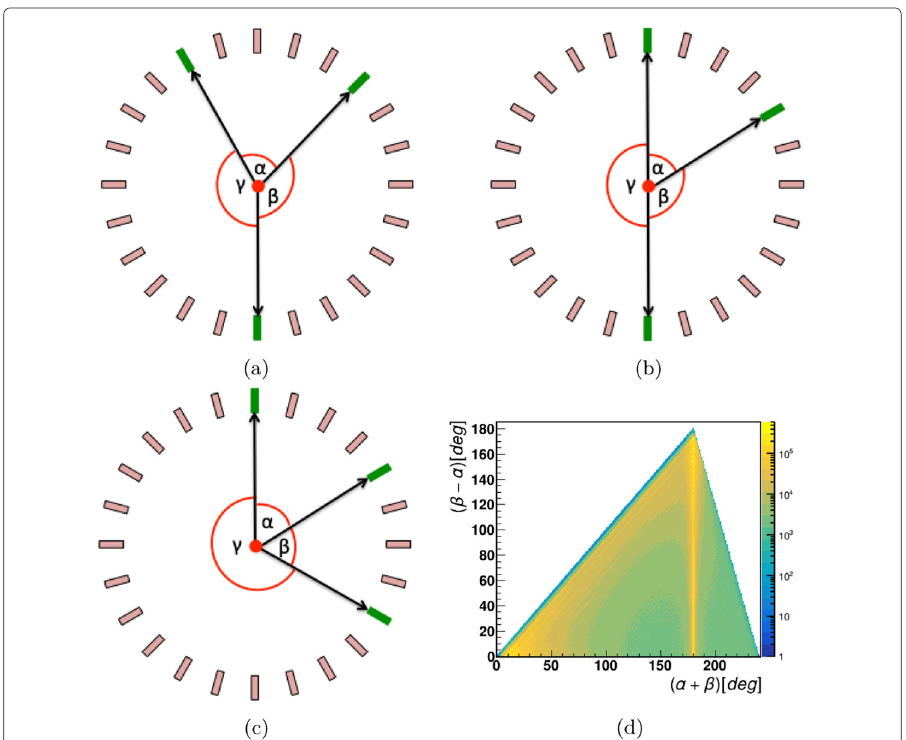
Fig. 6 a – c The three cases based on the angular correlation between the 3 hits in an event. The origin of the visualized events is explained in the text. a The case when the sum of two smallest angles is greater than 180 ◦ . b The case when sum is 180 ◦ . c When the sum of two smallest angles is less than 180 ◦ . d The measured scatter plot of the difference ( β − α ) vs the sum ( α + β ) of the two smallest angles time difference between the measured time (time difference between two hits) and calcu- lated time (distance between hit-positions divided by the speed of light). The S test was applied event-wise assuming both possibilities that the third hit might belong to the scat- tering photon after hit 1 or hit 2. The results are shown in Fig. 7b. In case of the proper assignment, the value of S should be close to zero. For the final analysis, events from the